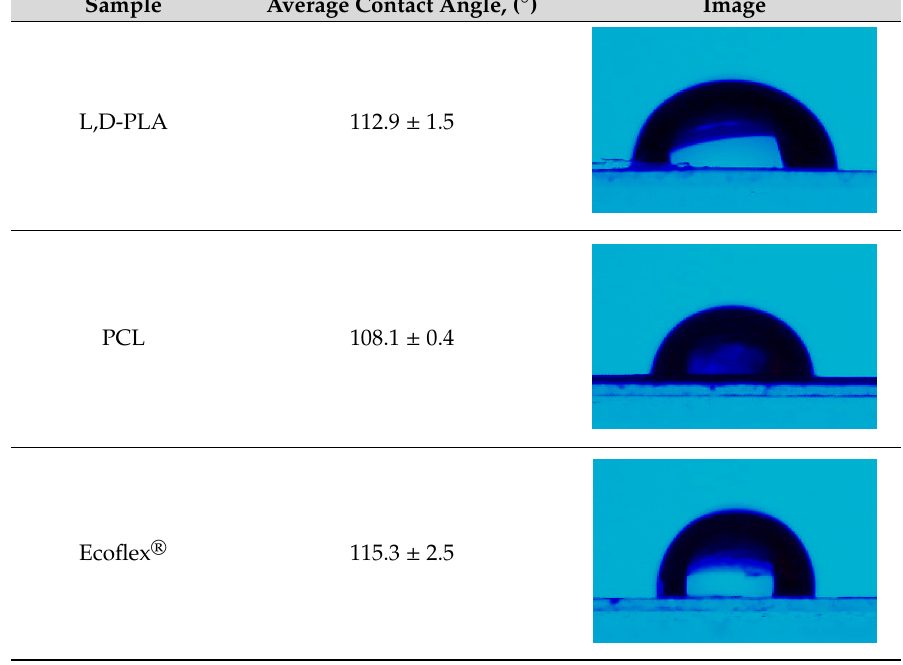
Table 3. Results of the contact angle measurements for the polymer layers without and with additives. Sample